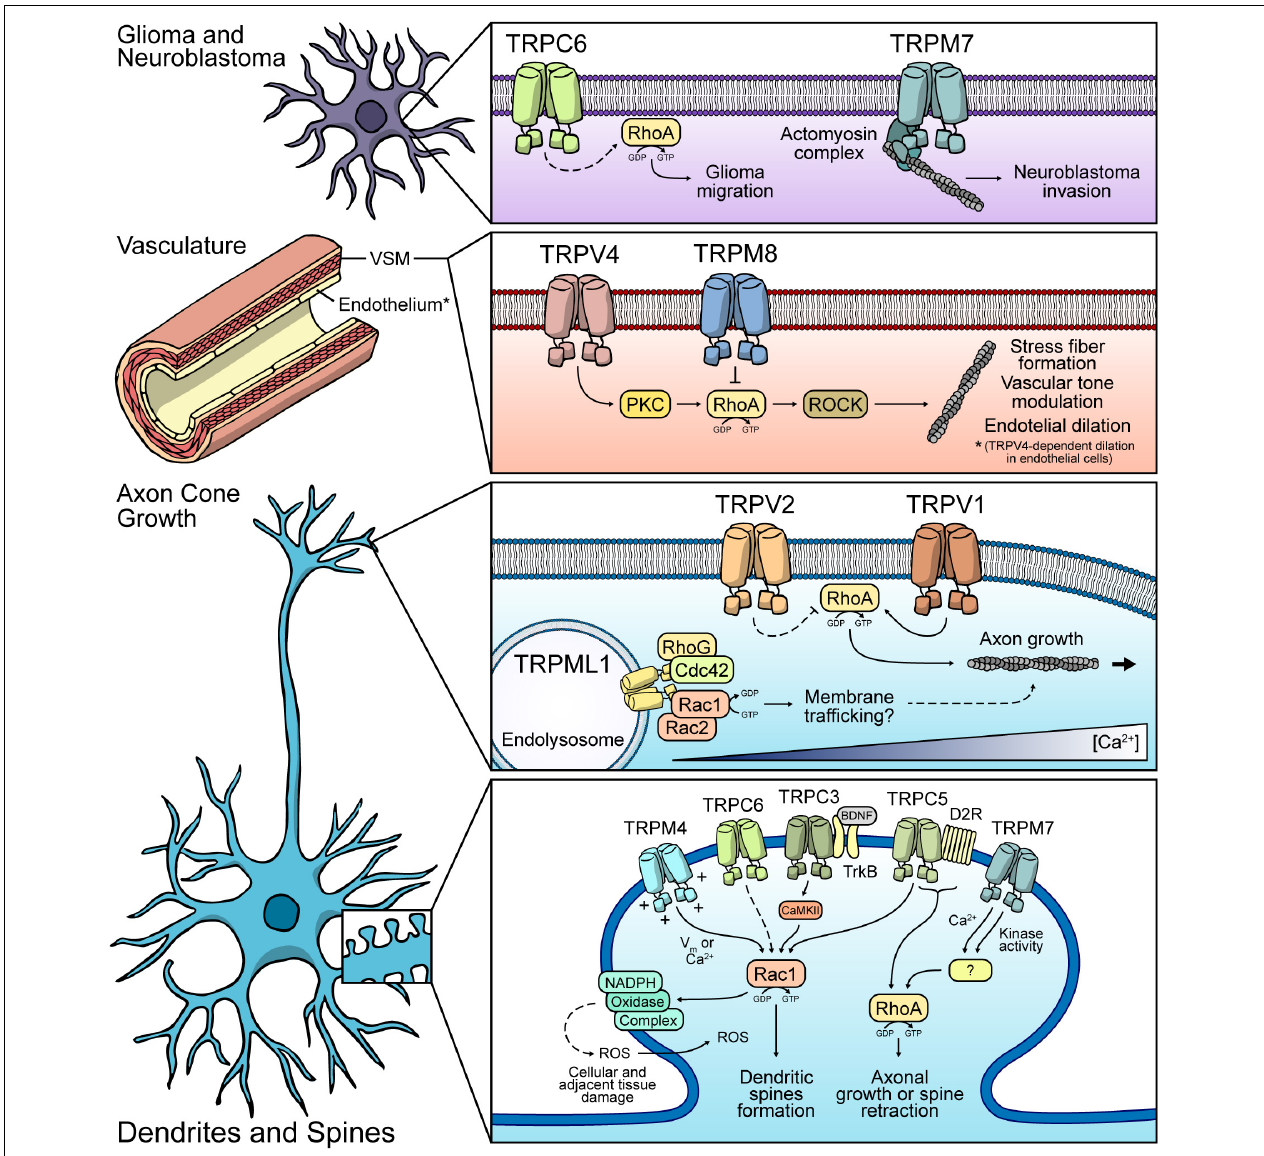
FIGURE 3 | Possible mechanisms of Rho GTPases modulation by TRP channels. Glia and Neuroblastoma: TRPC6 might modulate RhoA in glial cells, thus regulating cell migration. TRPM7 participates in neuroblastoma invasion. Vasculature: TRPV4 and TRPM8 display the opposite effect over RhoA. Both channels modulate vasculature tone. TRPV4 promotes endothelial dilation in a RhoA-dependent fashion. Axon cone: TRPML1-dependent regulation of protein trafficking via modulation of Rac1/Cdc42 might occur. TRPV1 promotes RhoA activity and modulates axonal growth. TRPV2 might have an inhibitory role of RhoA. Dendrites and spines: TRPM4, TRPC3, TRPC6, and TRPC5 might induce Rac1 activity, leading to dendritic spines formation. Under ischemic conditions, these channels might have a Rac1-dependent role in ROS production, leading to neuronal cell death. TRPM7 and TRPC5 are proposed to regulate RhoA, favoring the retraction of dendritic spines or axonal